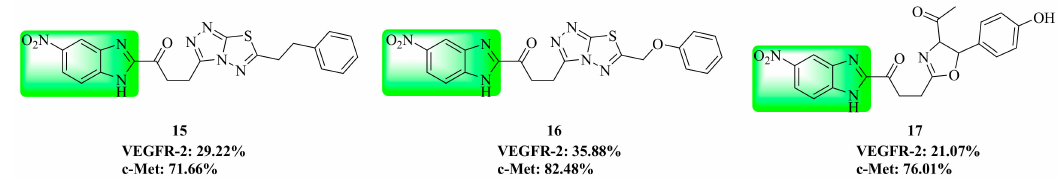
Figure 8. Benzimidazole derivatives of dual VEGFR / c-Met inhibitors.